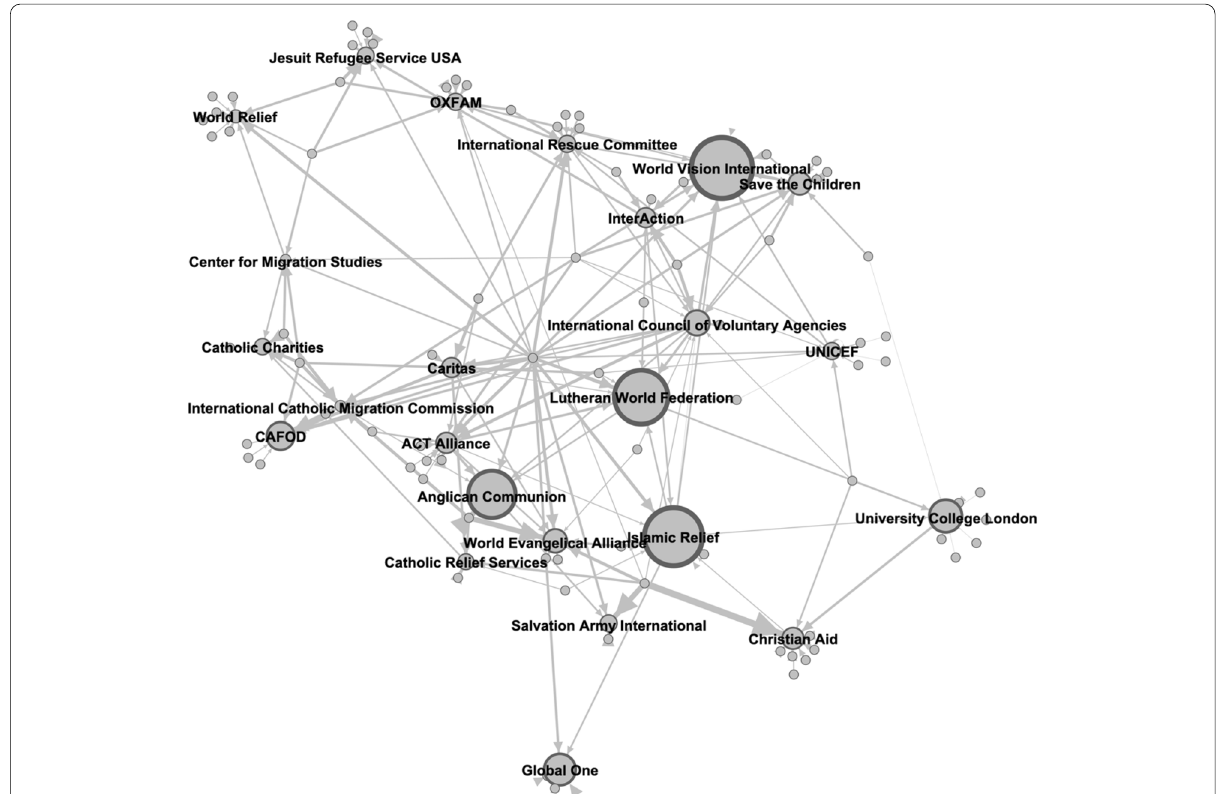
Fig. 2 Policy network showing eigenvector centrality, with node size scaled by eigenvector centrality scores